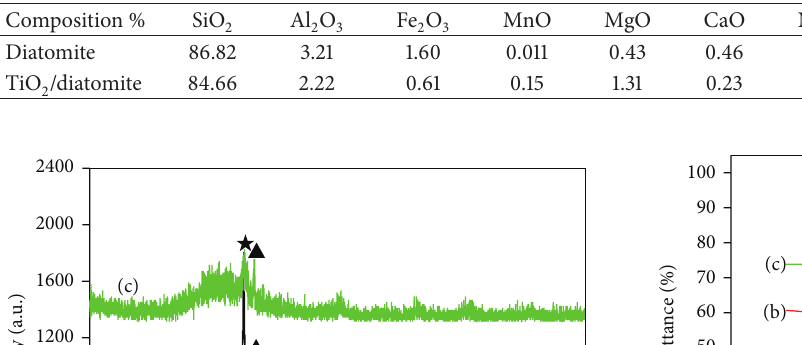
/diatomite composite. 2